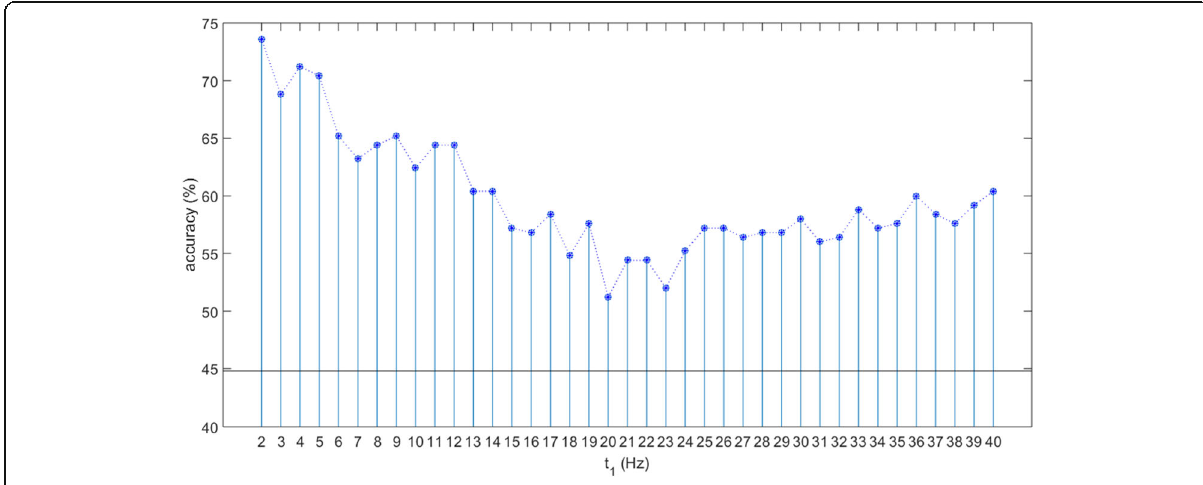
Fig. 6 Obtained accuracy results for N = 1 ( t 1 = 2:40). Black line denotes the accuracy for N = 0 (44.80%)